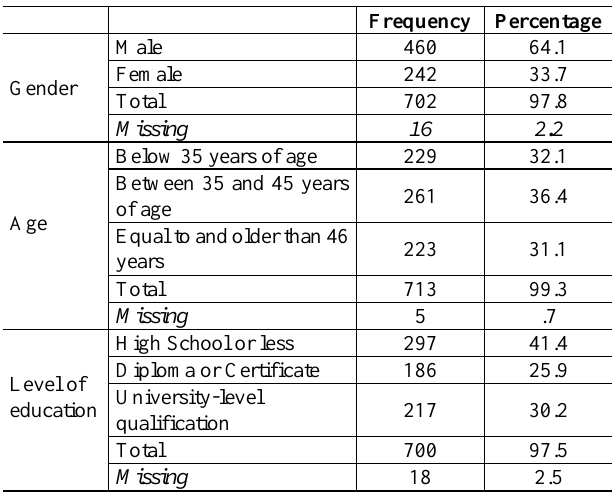
Table 1: Biographical characteristics of the